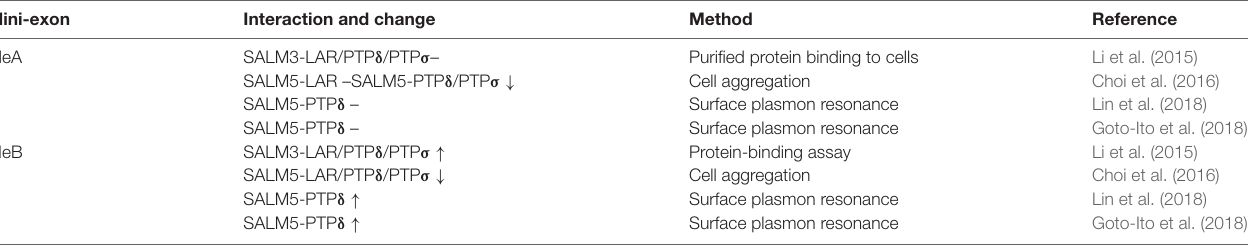
TABLE 1 | Influences of meA/B splice inserts in LAR-RPTPs on the interaction between LAR-RPTPs and SALMs. Mini-exon Interaction and change Method Reference